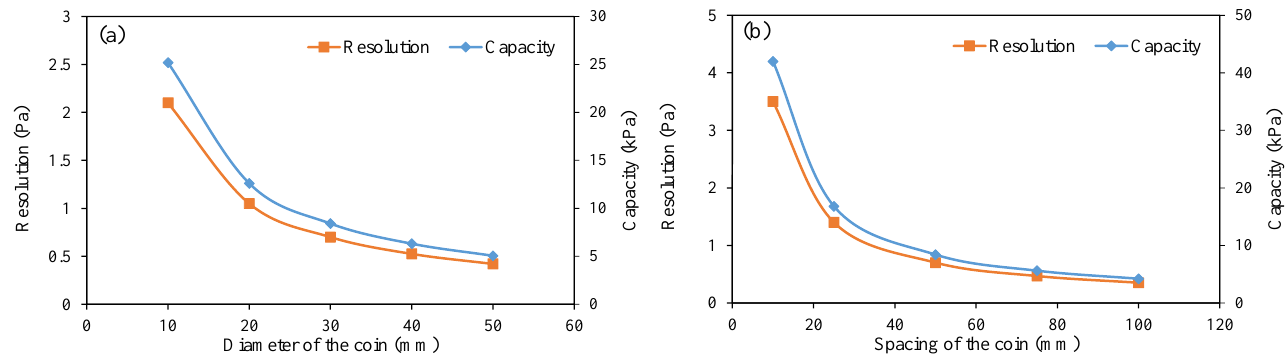
Figure 8. Resolution and capacity of the OFDR coin sensors with different coin diameters ( a ) and spacings ( b ).